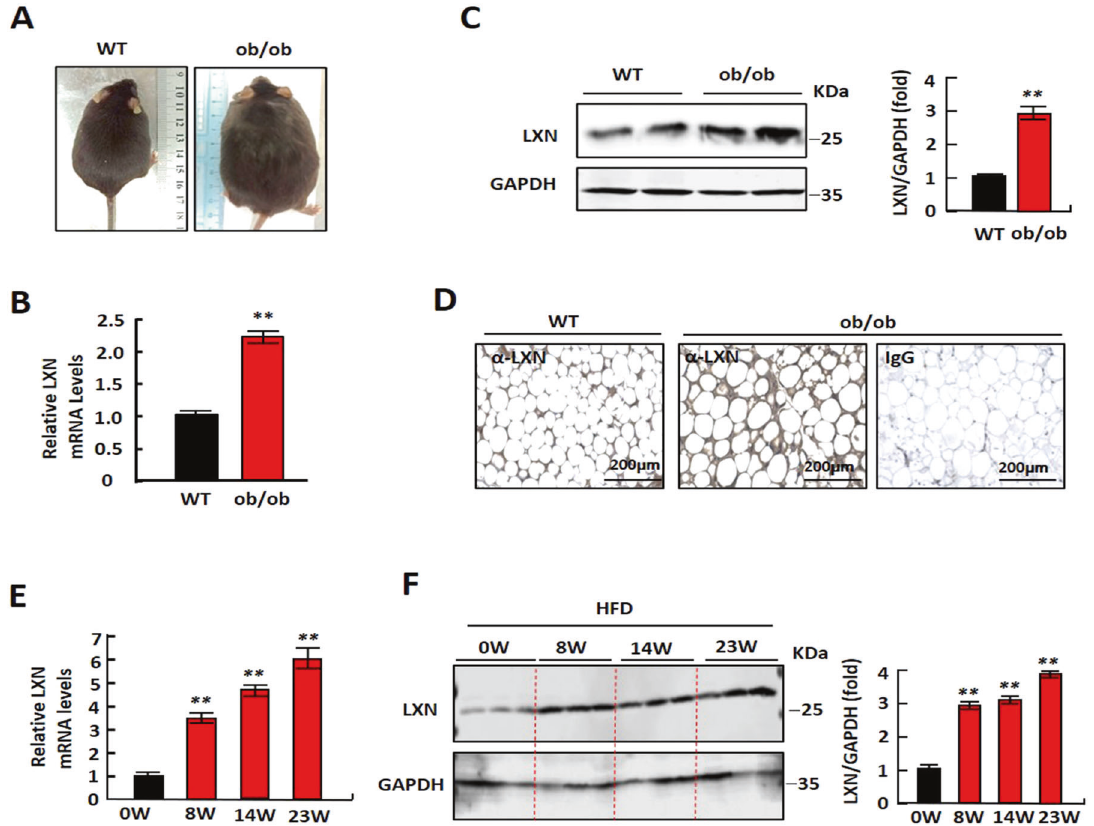
Fig. 1 Enhanced expression of LXN in obese mice. A Representative pictures for WT and ob/ob mice after feeding with normal diet (ND) for 16 weeks. B , C QPCR (B) and Western blot (C) analysis for LXN in the subcutaneous adipose tissue of WT and ob/ob mice. The bar graphs showing the results of all animals examined. Data are mean ± SD. ** P < 0.01 vs. WT. D Immunohistological analysis of LXN expression in adipose tissues of WT and ob/ob mice. Scale bars, 200 μ m. E , F 8-week-old male C57/B6 mice ( n = 6) were fed with high fat-diet (HFD) for additional 8, 14 or 23 weeks, then adipose tissue were harvested. LXN was determined by QPCR ( E ) and western blot ( F ). The bar graph shows quanti fi cation of LXN level in all animals examined. ** P < 0.01 vs. 0